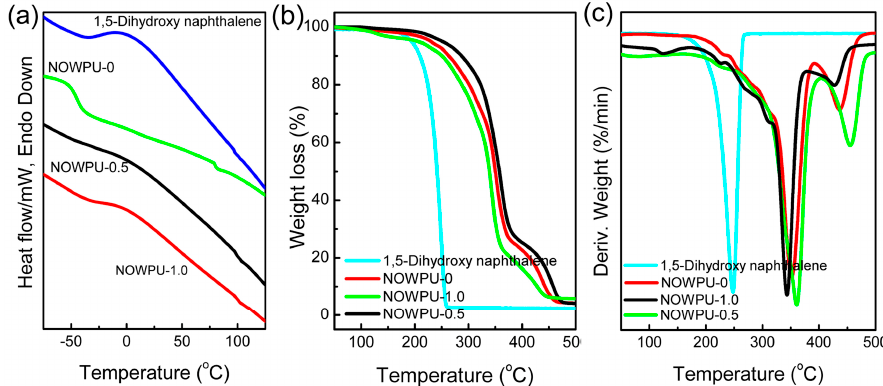
Figure 6. ( a ) DSC (differential scanning calorimetry) curves; ( b ) TGA (thermogravimetric analysis) curves and ( c ) DTG (differential thermal gravity) curves of NOWPU films. Table 2. Glass-transition temperatures of NOWPU films.